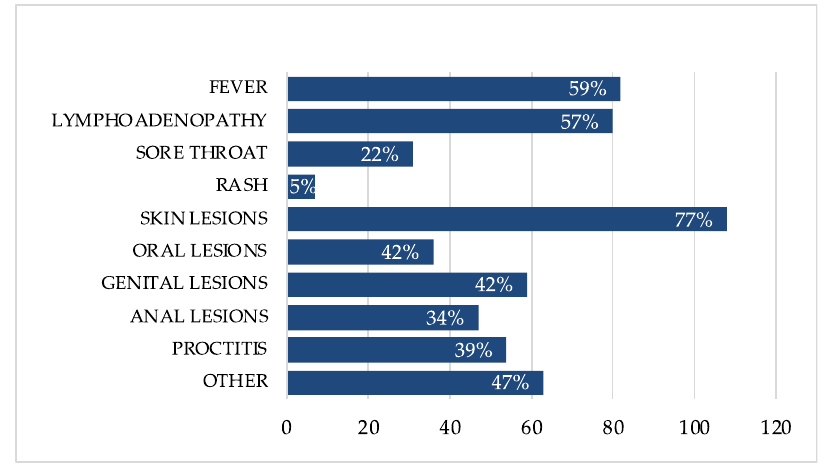
Figure 2. Clinical presentation of mpox in all 140 individuals.